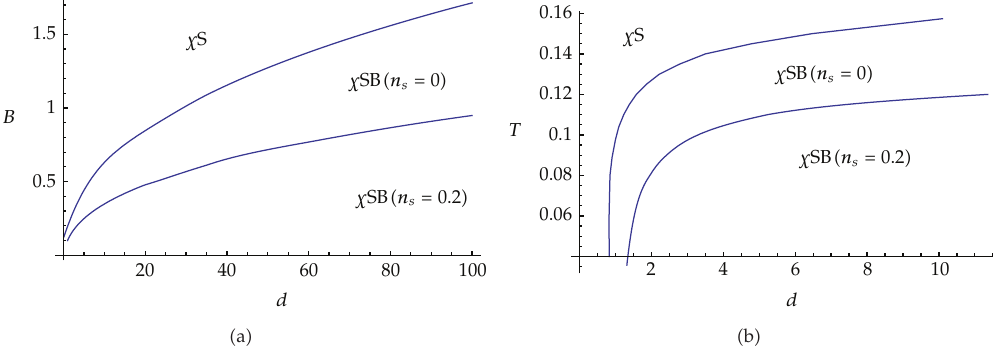
Figure 19: The phase diagram of the dense nuclear phases involving multiquarks when gluons are deconfined for (cid:3) a (cid:4) T (cid:8) 0 . 10 and (cid:3) b (cid:4) B (cid:8) 0 . 20. The chiral-symmetric quark-gluon plasma and the chirally broken MQ- ∇ ϕ phase are represented by χ S and χ SB, respectively, n s is the number of colour strings in fractions of 1 /N c